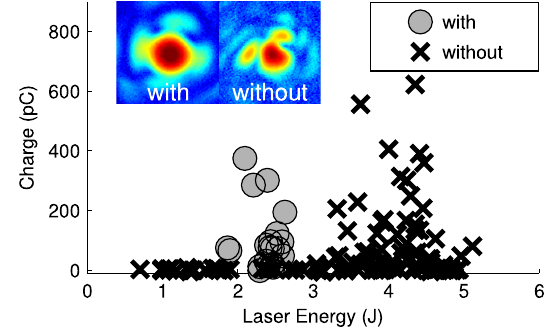
FIG. 4. (Color) Total beam charge Q measured on L1 as a function of input laser energy with and without the aperture in position, for P ¼ 95 mbar . Inset: Images of the focal spot with and without the aperture, on a logarithmic scale to emphasize features in the wings of the pulse.